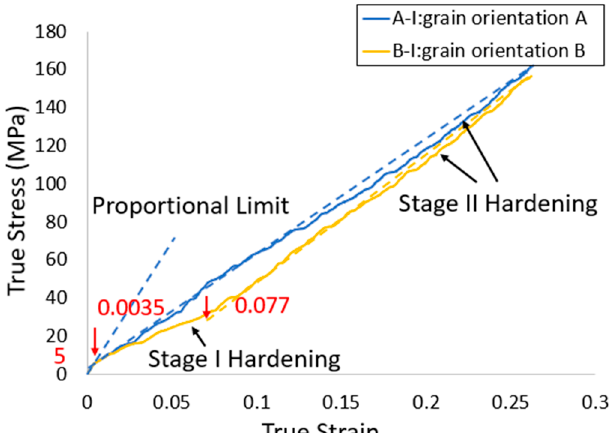
Figure 4. The true stress-true strain curve for single crystals pure aluminum with orientation A (A-I) and orientation B (B-I) deformed at 0.002/s in one-directional PSC. The value of hardening rate is taken as the slope of the trendline from the data points.